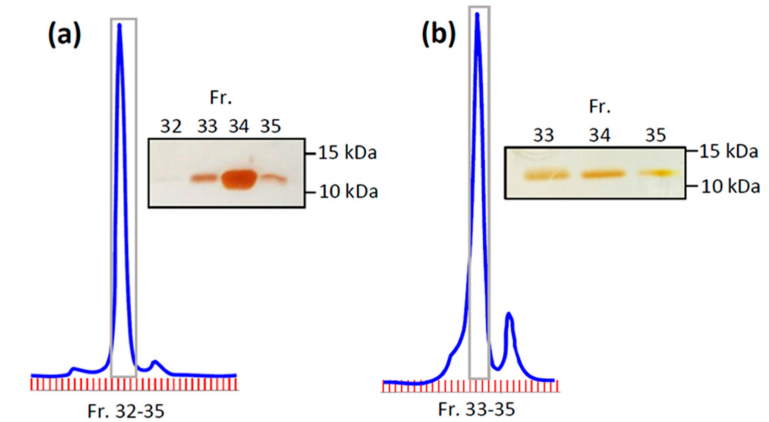
Figure A4. Purification of CCL15 chimeras ( a ) CCL15(N-CCL7) and ( b ) CCL15( ∆ 28). Each panel shows the preparative size exclusion chromatogram in dark blue and SDS-PAGE gel under non-reducing conditions of the selected fractions (indicated in light grey boxes on the